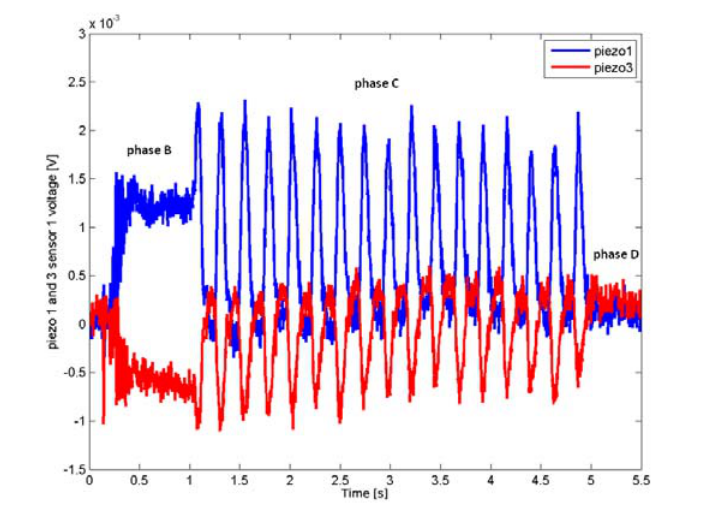
Figure 10. Time plot showing the opposite sign of the variation of the readings from piezoresistors 1 and 3 of MEMS 1 during sliding. The plot refers to data series 1, where a grating of 3.6 mm spatial periodicity was applied with translational speed of 15 mm/s, according to Tables 2 and